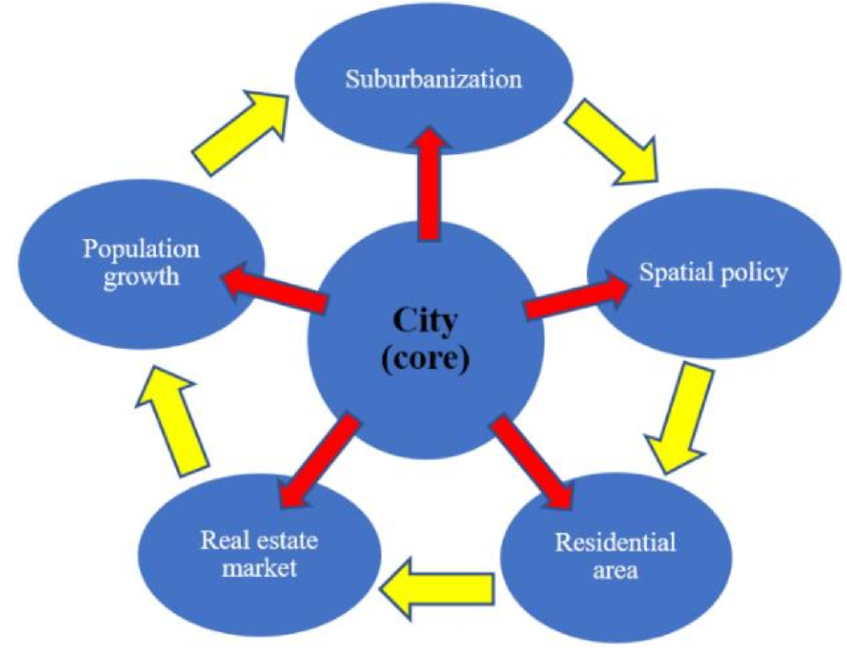
Figure 1. The urbanization cycle. Source: